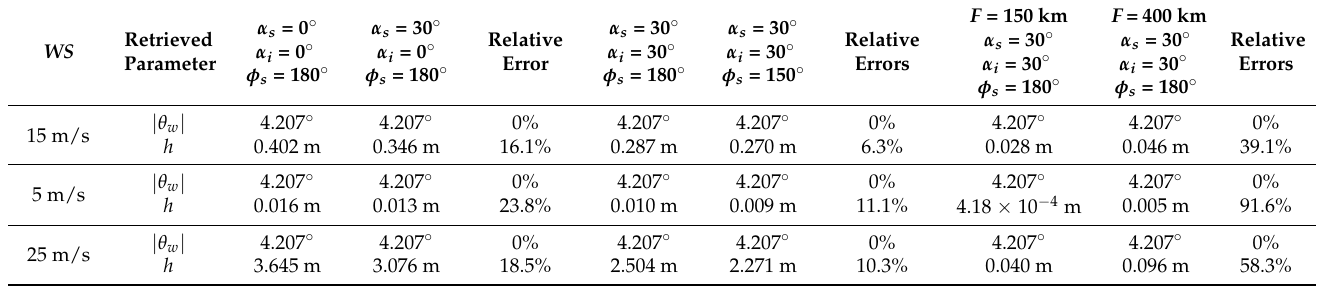
Table 2. | θ w | and h retrieval values as well as relative errors with φ w = 30 ◦ .